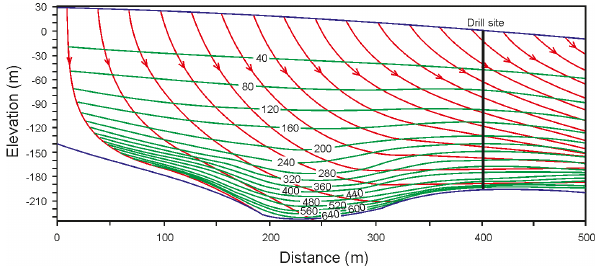
Figure 11. Vertical transect of the western Elbrus plateau glacier along a reference flow line. Predicted ice-particle paths (lines with arrows) and isochrones are